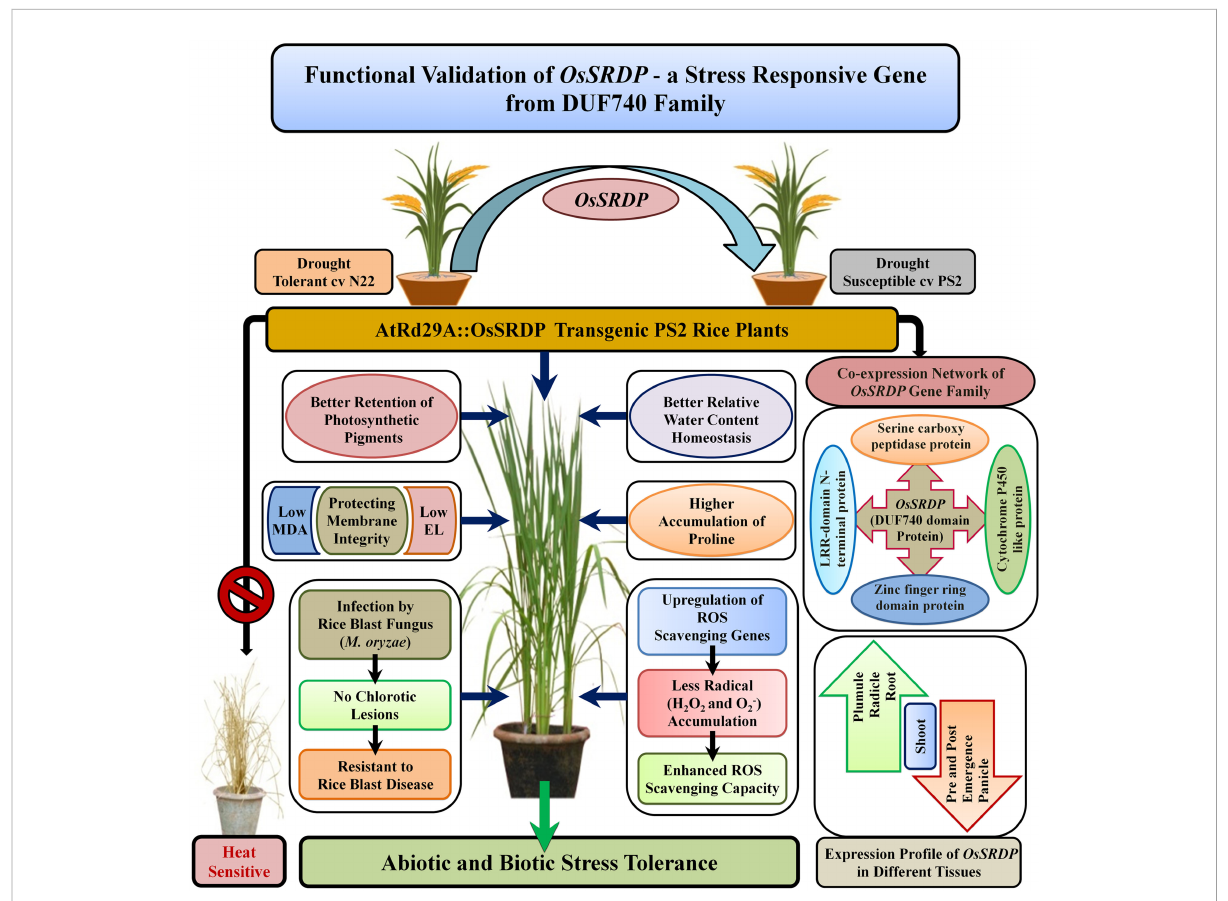
FIGURE 9 A proposed model depicting the function of the OsSRDP ( LOC_Os04g59420 ) gene, a member of the DUF740 family, in the regulation of multiple abiotic stresses and biotic stress tolerance. Stress-inducible expression of OsSRDP in transgenic PS2 rice plants exhibited enhanced tolerance to drought, salt, and cold stresses through higher plant water status, photosynthetic pigments, osmo-protectant accumulation, enhanced ROS scavenging capacity through upregulation of ROS scavenging genes, lower accumulation of lipid peroxidation (MDA), and minimal cell membrane injury. In addition, the transgenic rice lines were also resistant to rice blast fungus M. oryzae